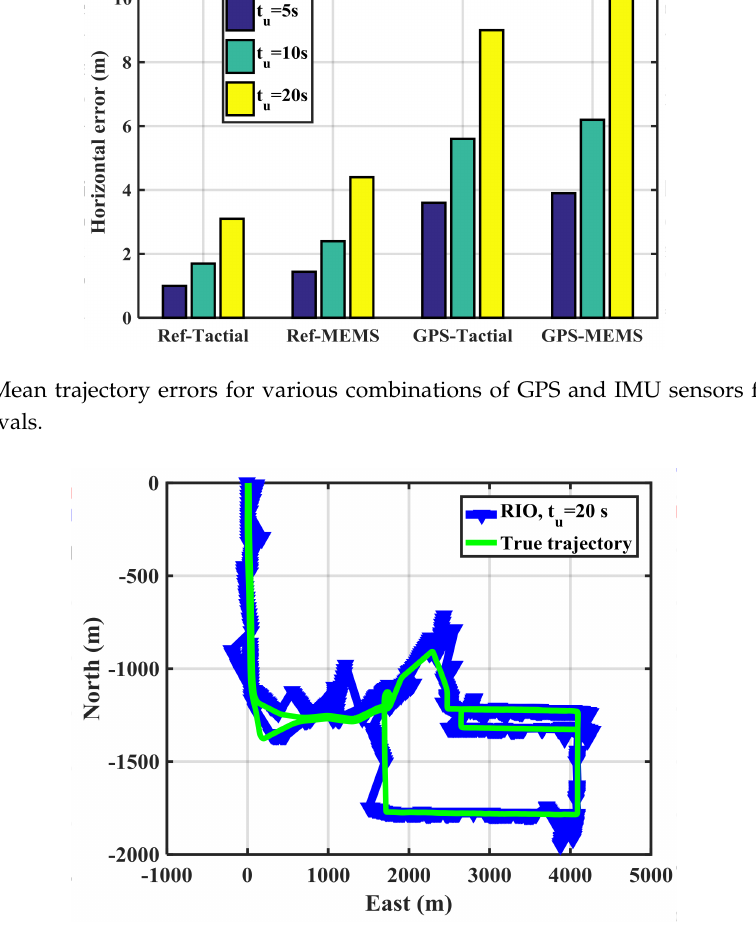
Figure 14. Horizontal trajectory for spoofed GPS, GPS/RIO, RIO with 20 s correction updates for MEMS